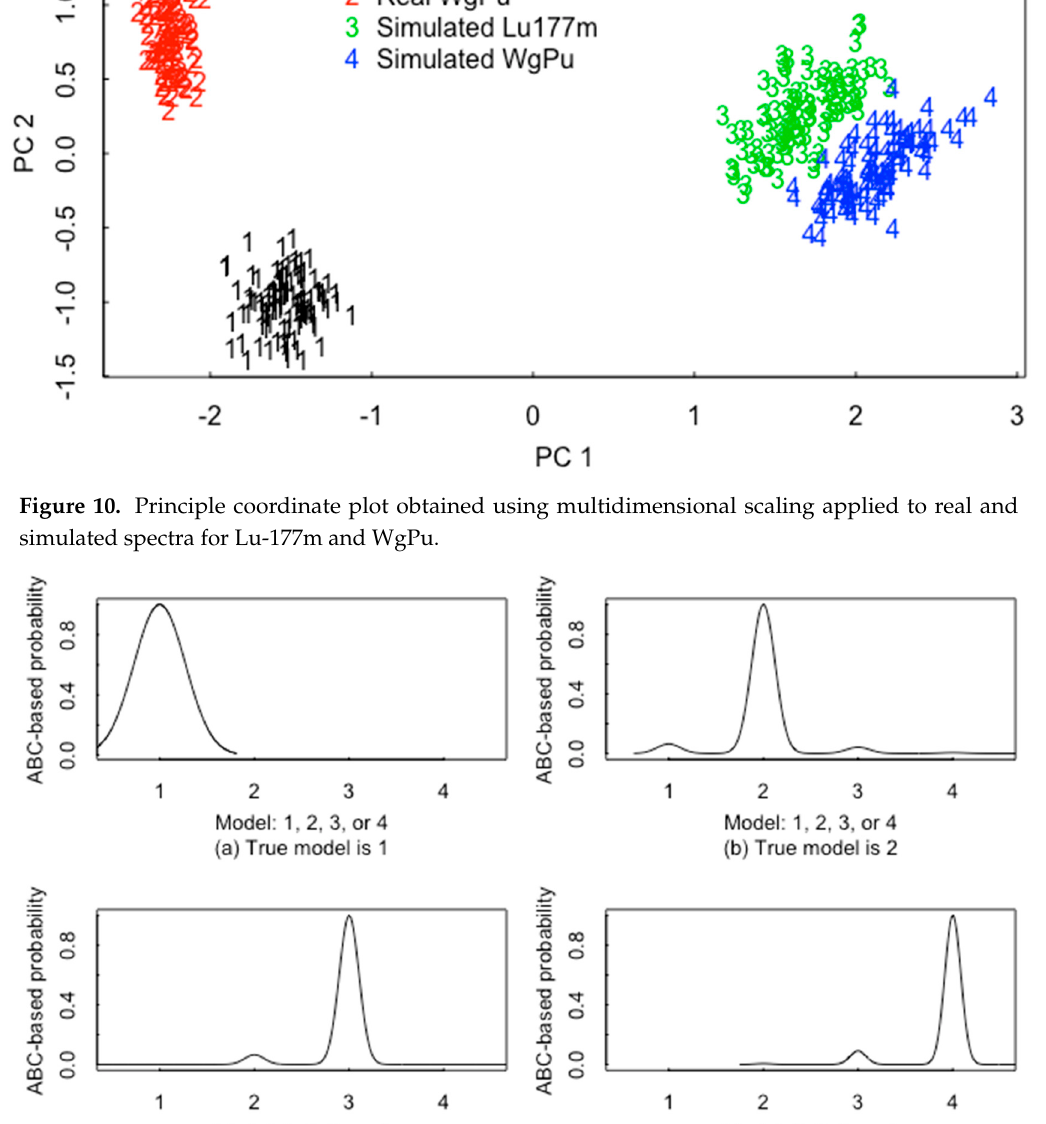
Figure 11. The ABC-based posterior probabilities for each of the 4 models (1–4) in Figure 10 using